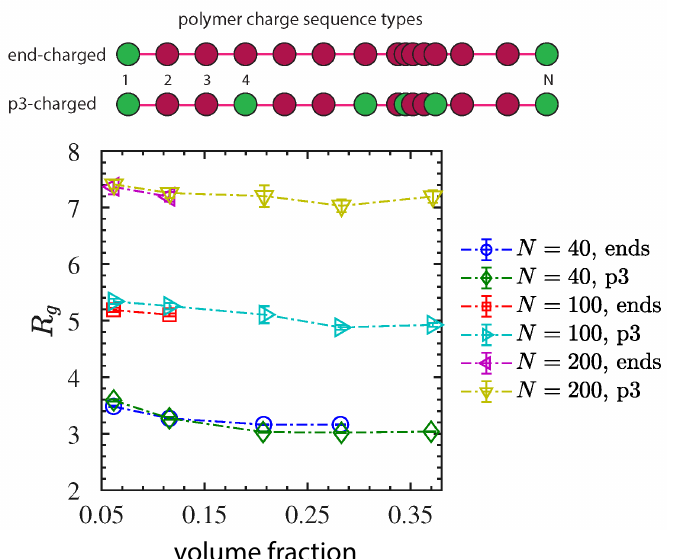
Figure 18. Radii of gyration R g (in units of bond length) of ionic polymers versus nanoparticle volume fraction for dispersed systems, by equilibrium molecular dynamics. Reprinted with permission from Moghimikheirabadi et al. [146].